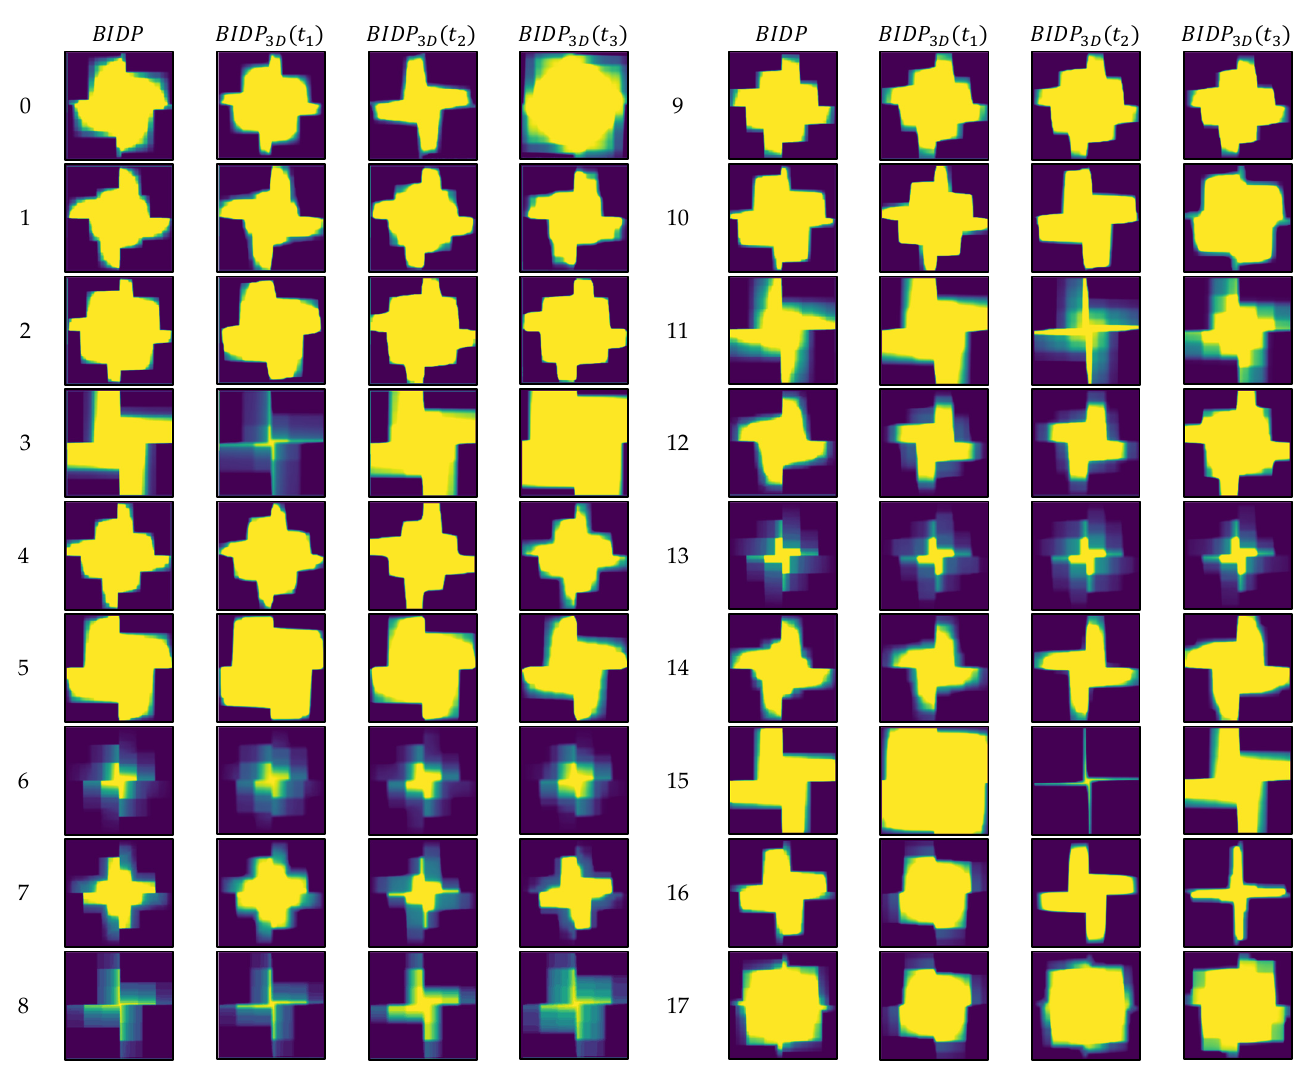
Figure 11. 𝐵𝐼𝐷𝑃 (cid:2871)(cid:3005) examples of 18 activities in the WISDM Dataset. Figure 11. BIDP 3 D examples of 18 activities in the WISDM